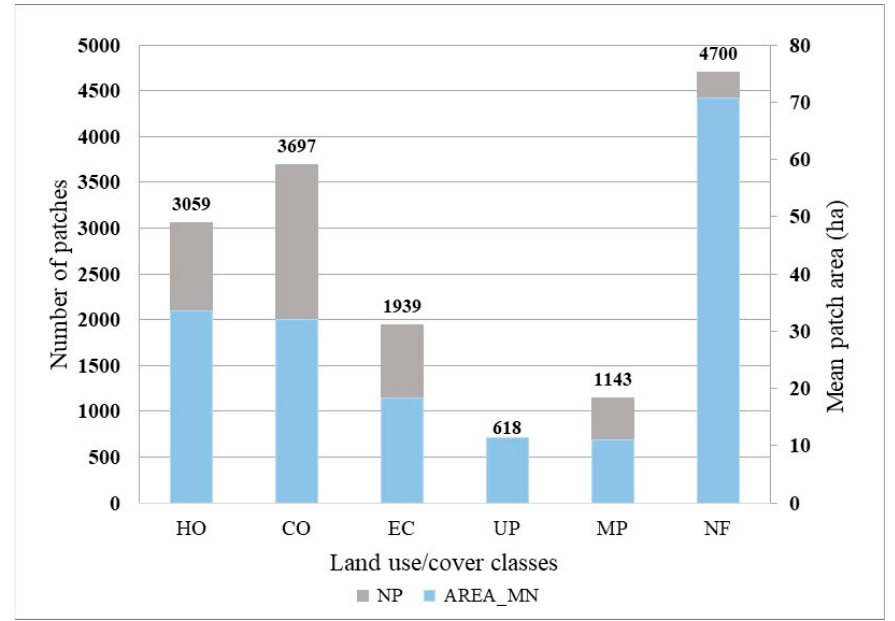
Figure 4. The number of patches (NP) and mean patch area (AREA_MN).